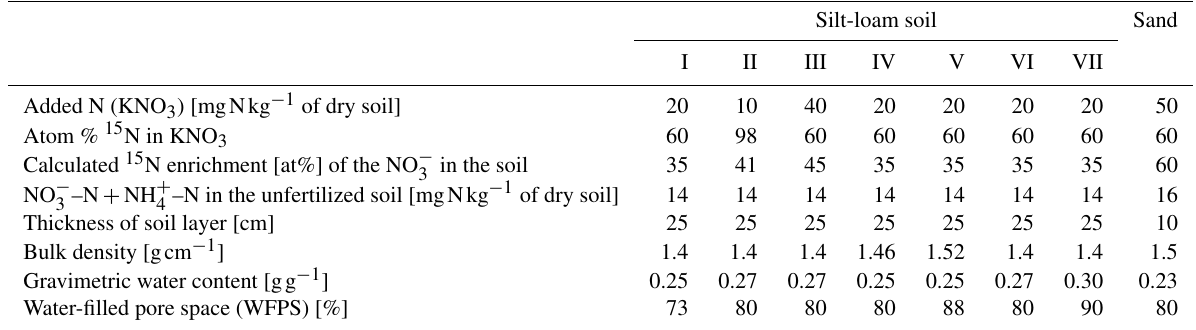
Table 2. Initial settings of laboratory incubations of soil from Fuhrberg (Sand) and Hattorf (silt-loam soil; treatments I to VII), Germany.